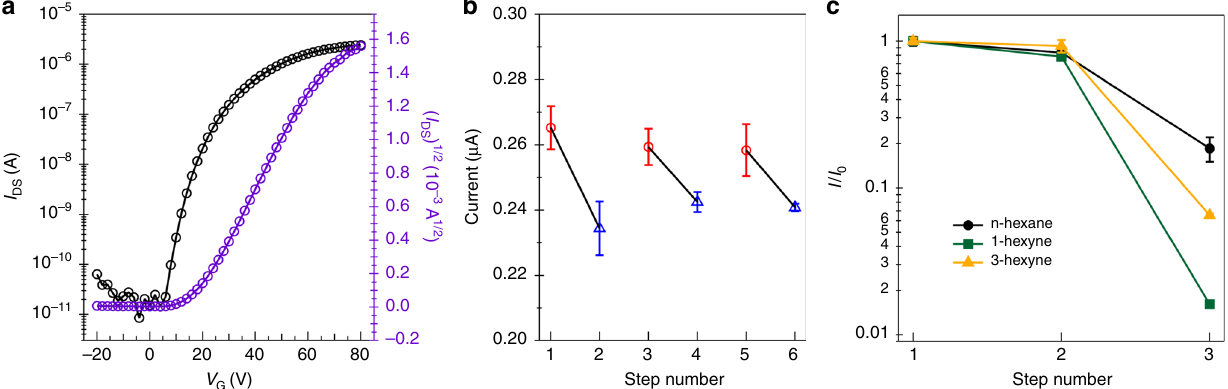
Fig. 4 Electron transport for cellular fi lms. a Transfer characteristics of OFET device for 1 -Br 12 . b Device cycling response under vacuum (red circles) and N 2 atmosphere (blue triangles). c Normalized behavior of the device response under vacuum (step 1), N 2 (step 2), and different analytes atmosphere (step 3: n-hexane, 3-hexyne and 1-hexyne). Error bars represent the standard error obtained in three measurements